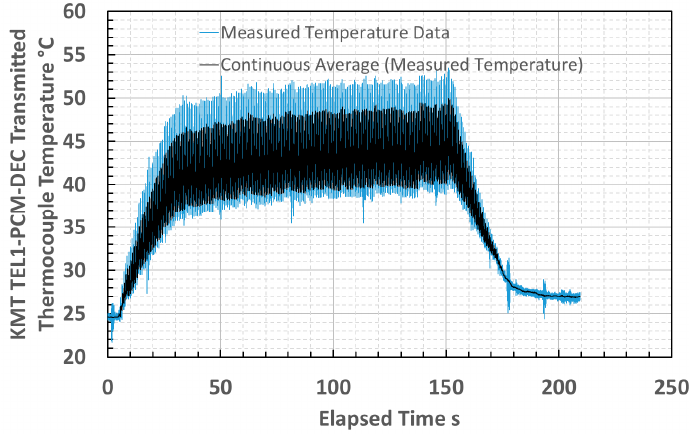
Figure 14. Cutting tool insert temperature measured by an embedded thermocouple from an early pass during end milling trials, illustrating broad comparability with temperatures measured by the prototype infrared thermometer.